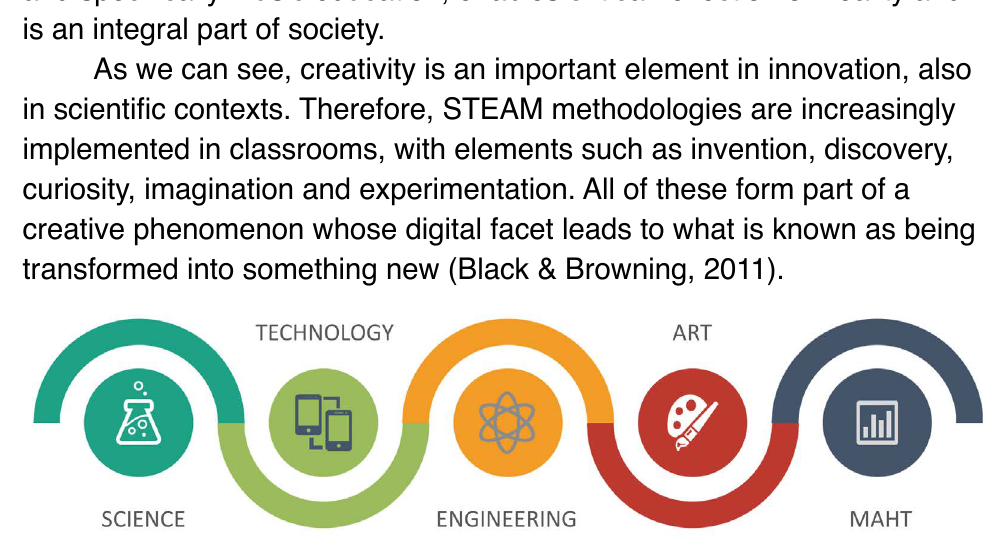
Figure 1. STEAM. Source: